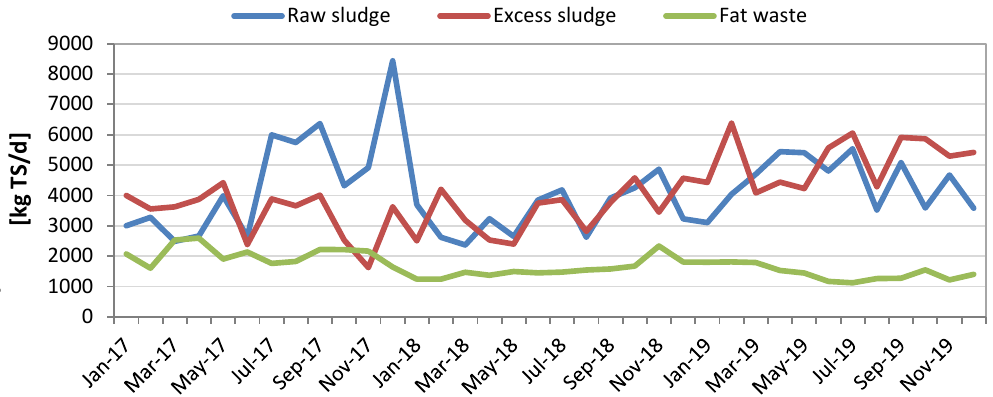
Figure 7. The daily flow of substrates supplied to the digester in the Iława WWTP.